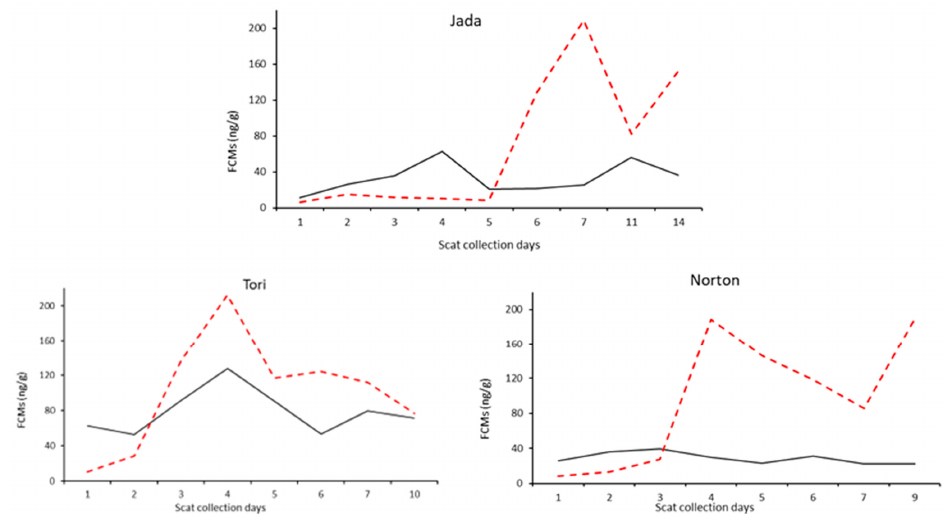
Figure 3. FCM (faecal cortisol metabolite) values of three koalas during the longitudinal study, showing an artificial increase one day after the systemic administration of synthetic GCs measured with the cortisol EIA (enzyme immunoassay; red dash line). The values of FCMs measured with the 50c EIA (black solid line) are within the normal variation expected for stressed koalas. The artificial increase is also evident in the 2-day scat collection of five koalas (Figure 4a). FCM values measured with the 50c EIA did not show any increase attributed to pred- nisolone treatment. Koala Ida’s first sample was lost. However, hospital records show that she received GCs from the day of admission and was on the medication at the time the second sample was collected.